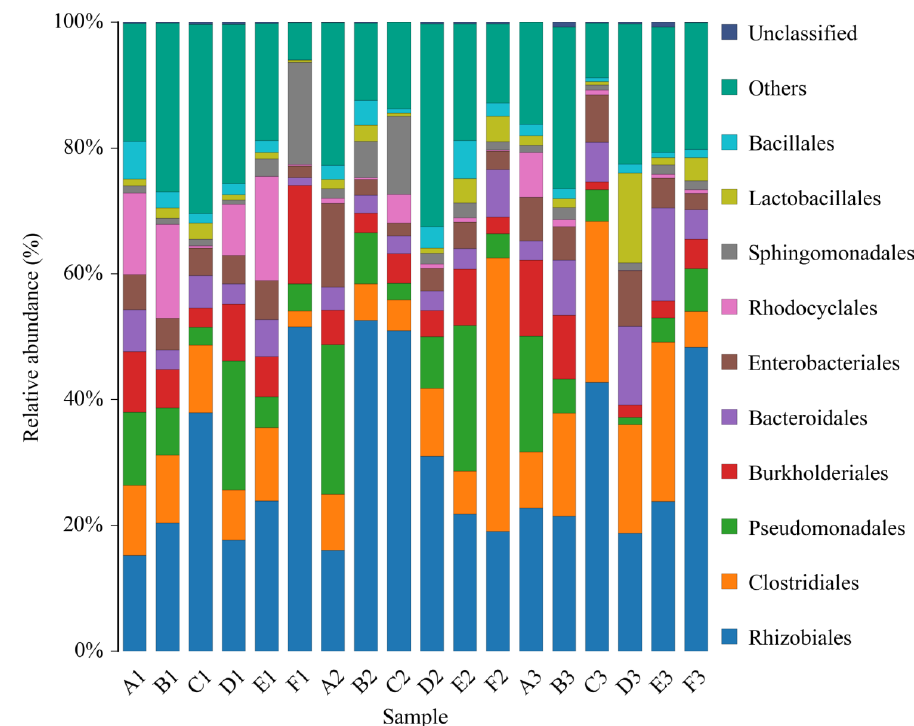
Figure 5. Order distribution in the samples.